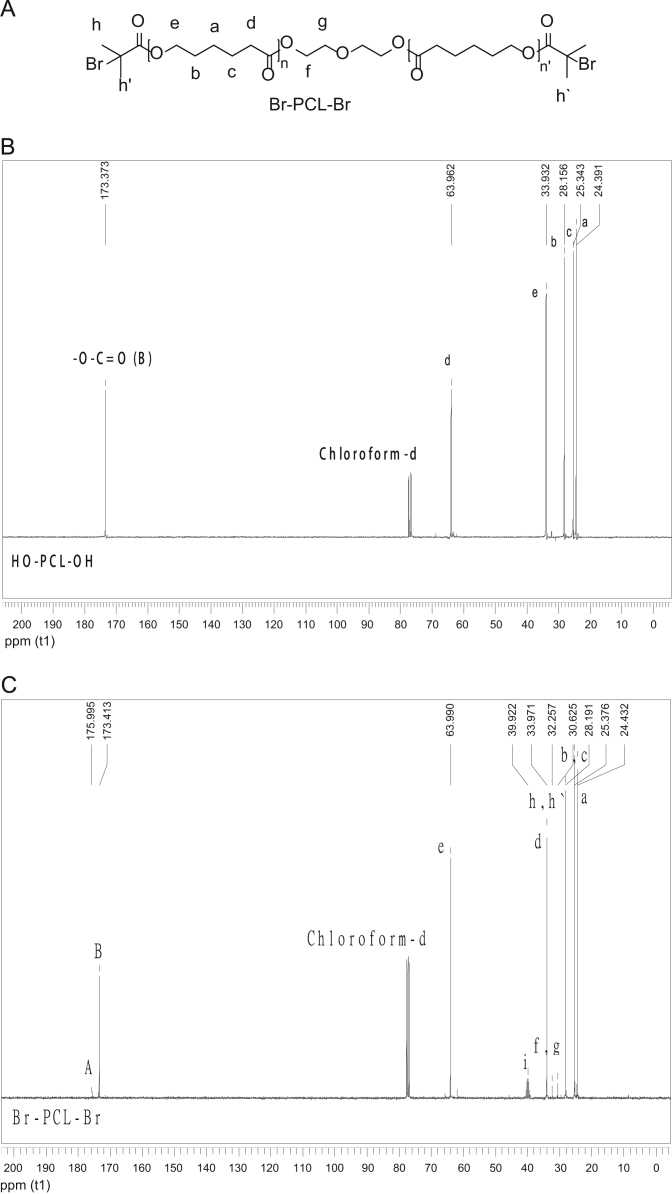
Macroinitiator Br-PCL-Br structure (A) and 13C NMR (CDCl3, 300 MHz) spectrum of PCL-diol (B) and Br-PCL-Br (C).